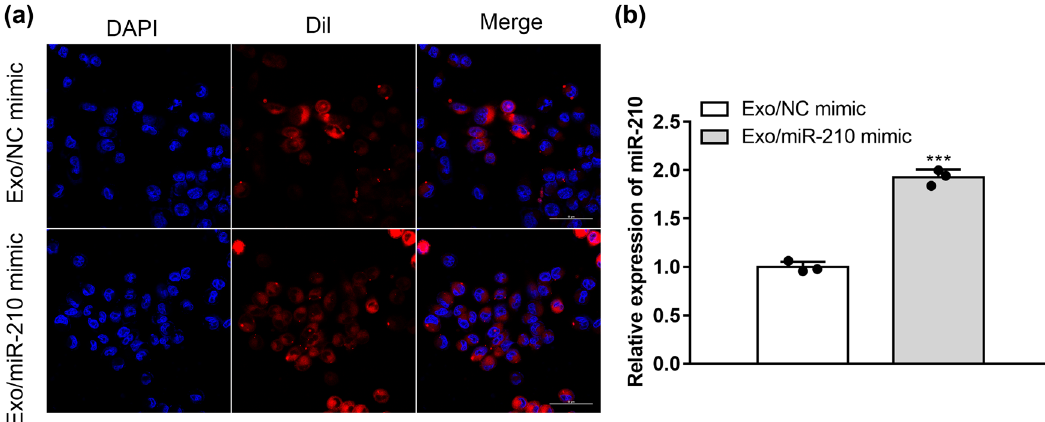
Figure 2: MSC - Exos localization in microglia. Dil - MSC - Exos were co - cultured with microglia for 24 h. ( a ) Representative immuno fl uores - cence image showing Dil - labeled ( red ) MSC - Exos inside microglia and with the nuclei stained with DAPI ( blue ) ( n = 3 ) . Scale bar: 50 μ m. ( b ) Gene expression of miR - 210 as measured by qRT - PCR ( n = 3 ) . *** P < 0.001 vs Exo/NC